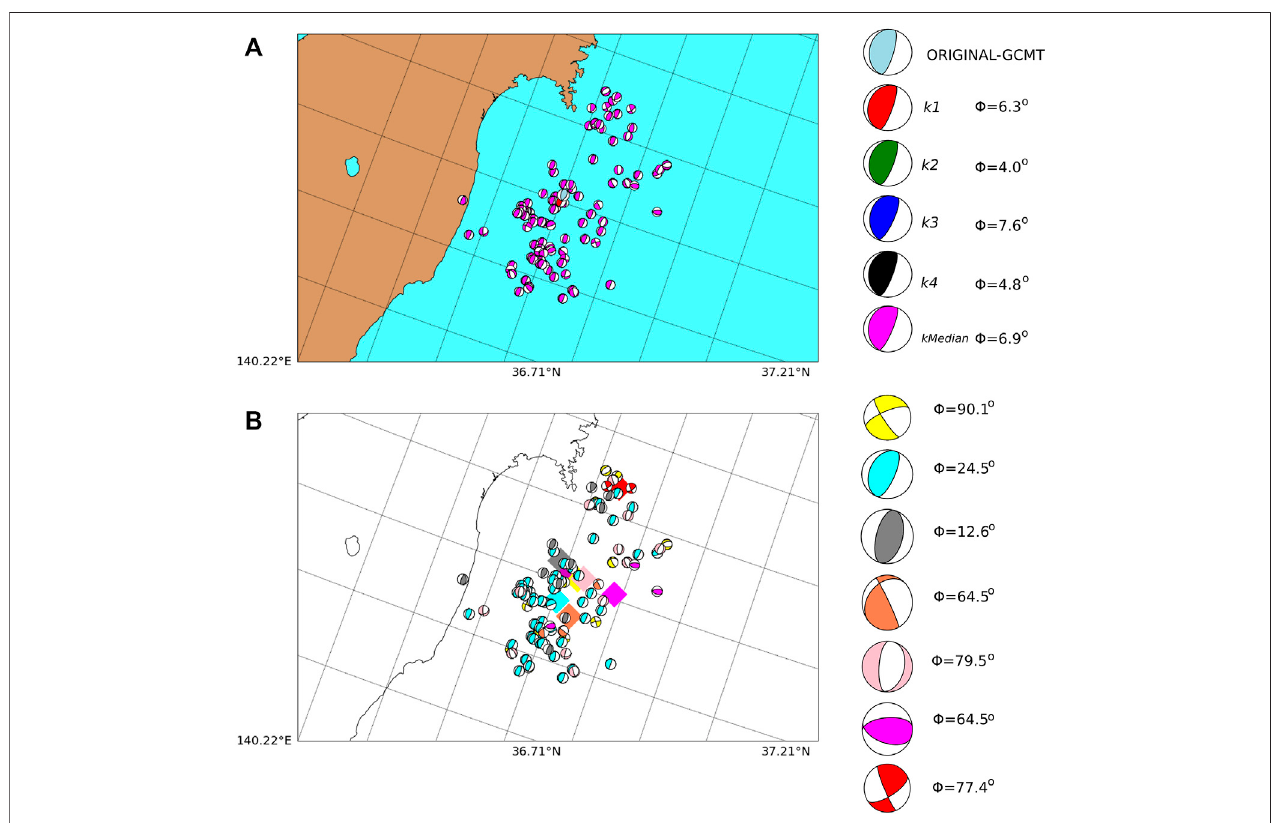
FIGURE 9 | Same as Figure 8 for an M w = 5.2 Japanese earthquake (see Table 3